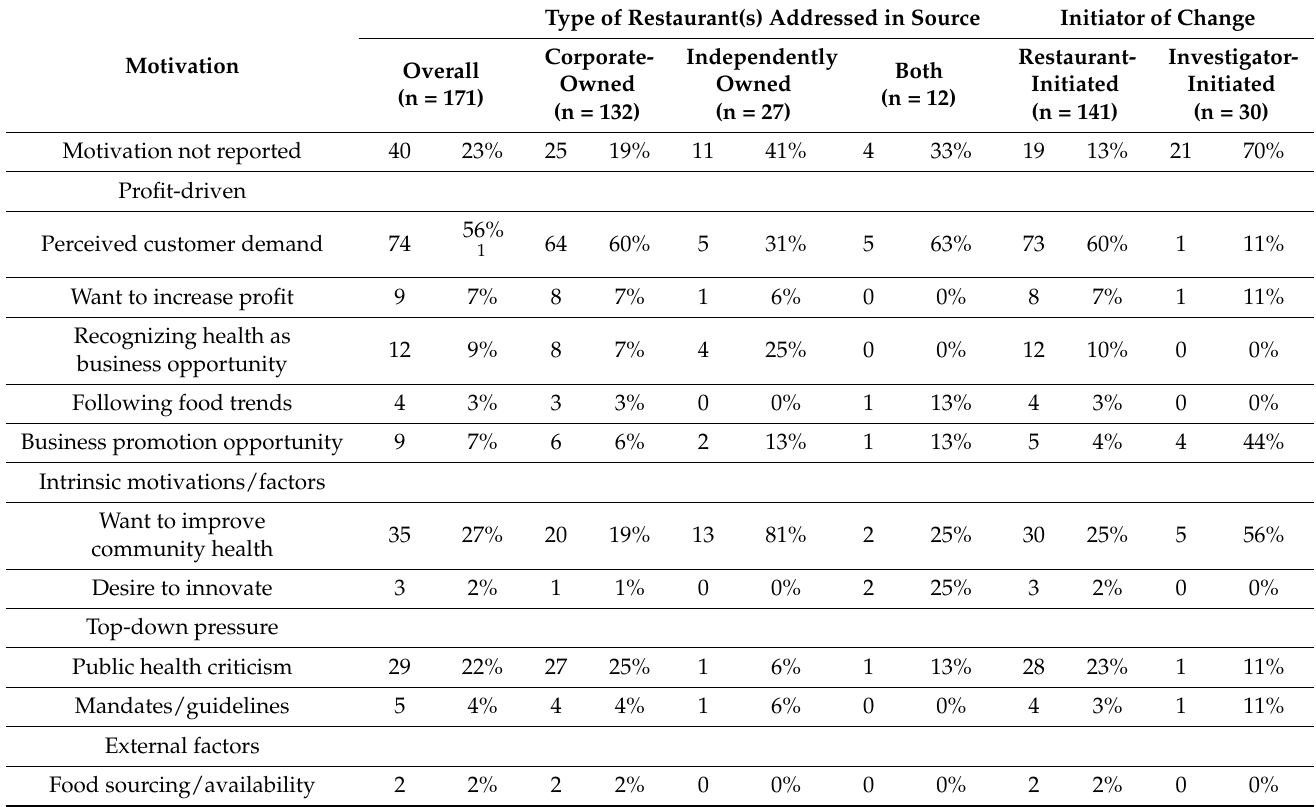
Table 2. Reported motivations for engaging in healthy eating promotion strategies, overall and stratified by restaurant type addressed and change